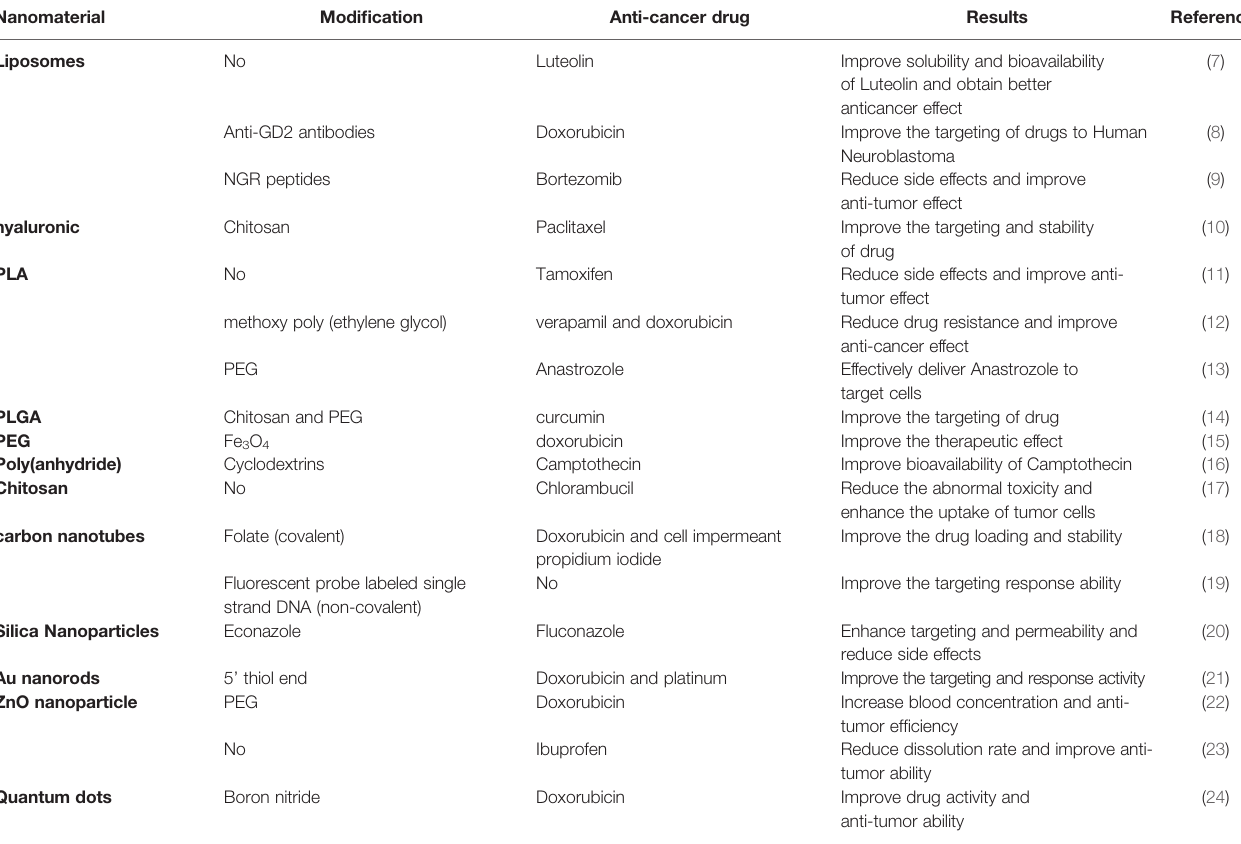
TABLE 1 | Different materials as anti-tumor drugs delivery